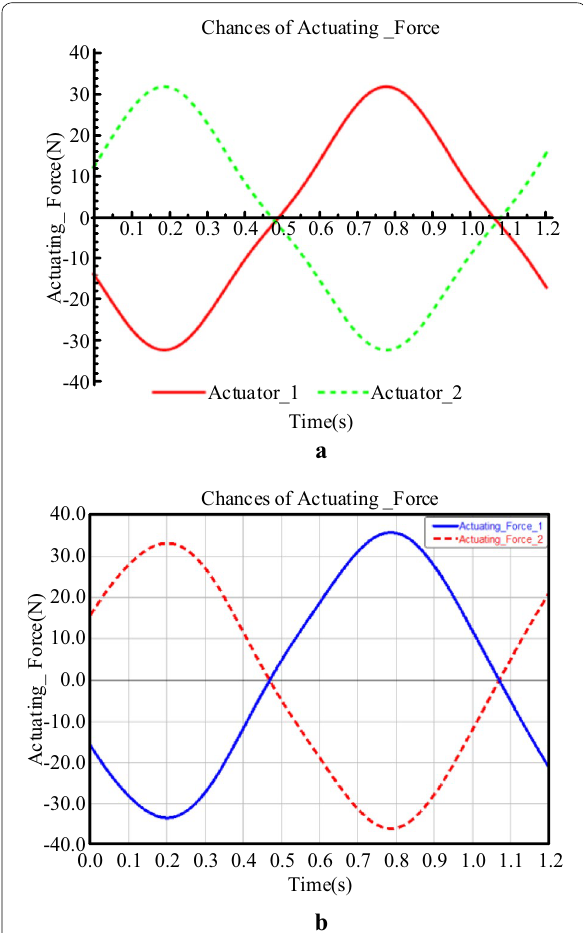
Figure 19 Actuating displacements in the first gait mode: a based on Matlab; b based on